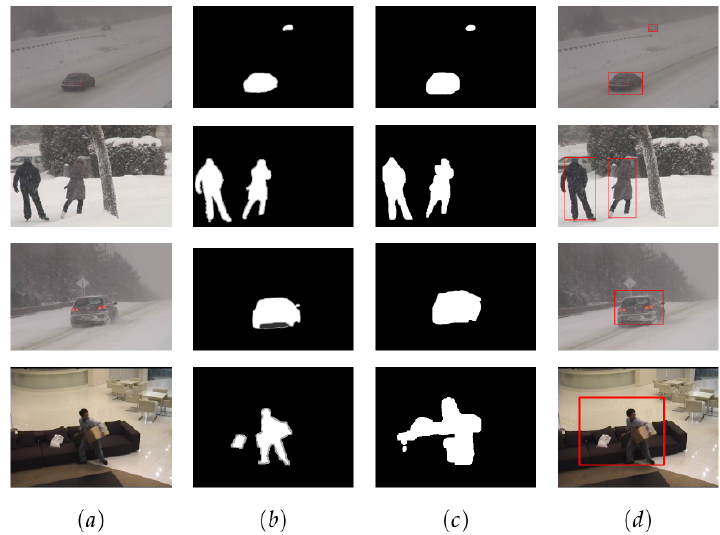
Figure 8. Results of our system applied to CD2014 images. Column ( a ) represents the image where change detection is applied, column ( b ) represents the ground truth images given by the CD2014 dataset, ( c ) the prediction images from our model and ( d ) the original images with the bounding boxes obtained by the prediction process.